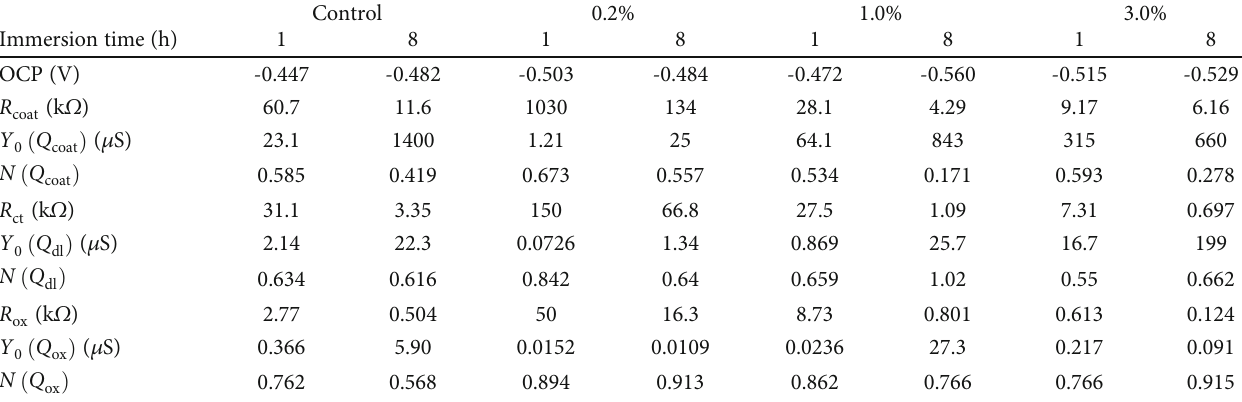
Figure 17: R ð RQ Þð RQ Þð RQ Þ equivalent circuit attributed to EIS results for samples coated with NO Table 7: Electrochemical parameters obtained after fi tting EIS data of coated samples to equivalent circuit R ð RQ Þð RQ Þð RQ Þ . Control